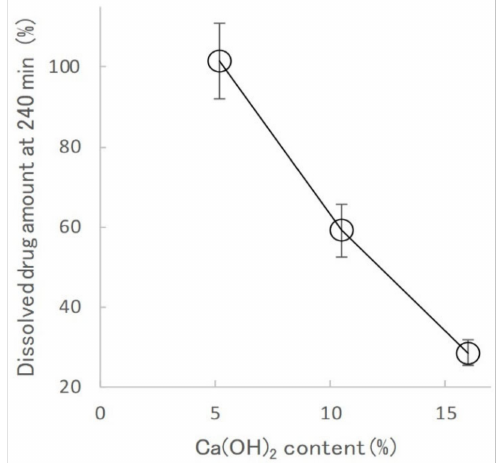
Figure 9. Effect of calcium hydroxide content on the RA4 of the KGM matrix tablets.